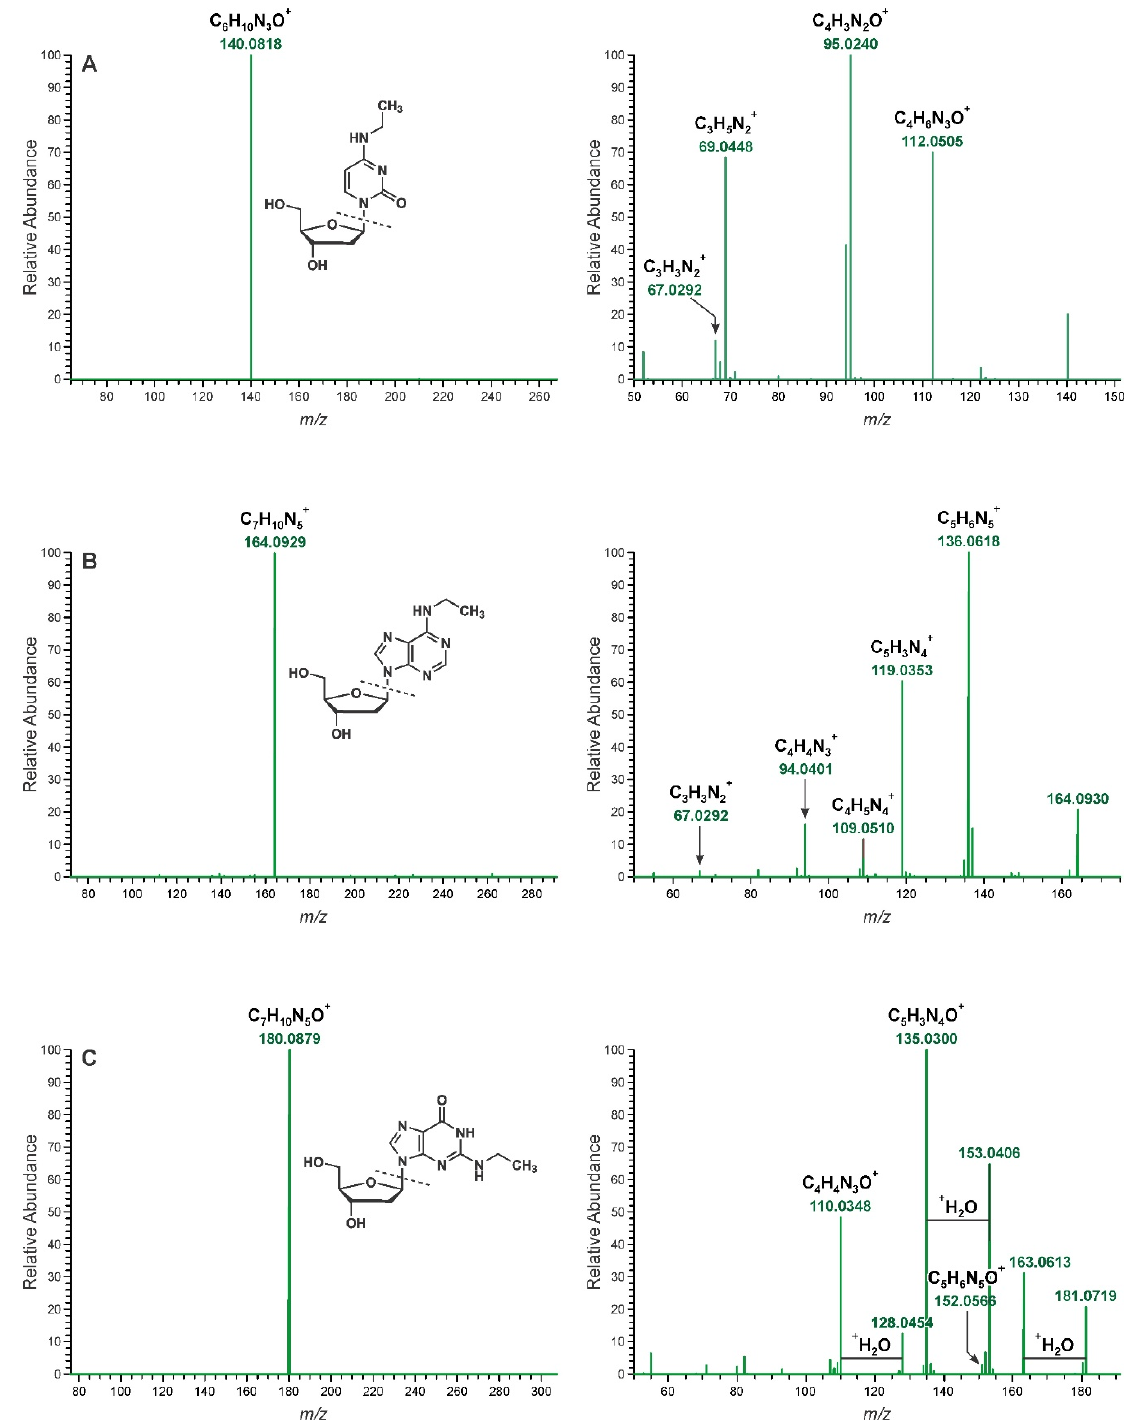
Figure 2. Most intense peaks detected in CT-DNA were assigned to N 4 -ethyl-dC ( m / z 256.1292), N 6 -ethyl-dA ( m / z 280.1404), and N 2 -ethyl-dG ( m / z 296.1353). Panel ( A ): N 4 -ethyl-dC MS 2 and MS 3 spectra with main fragment structures elucidated. Panel ( B ): N 6 -ethyl-dA MS 2 and MS 3 spectra with main fragment structures elucidated. Panel ( C ): N 2 -ethyl-dG MS 2 and MS 3 spectra with main fragment structures elucidated. The three structures were confirmed by comparison with synthetized standards.